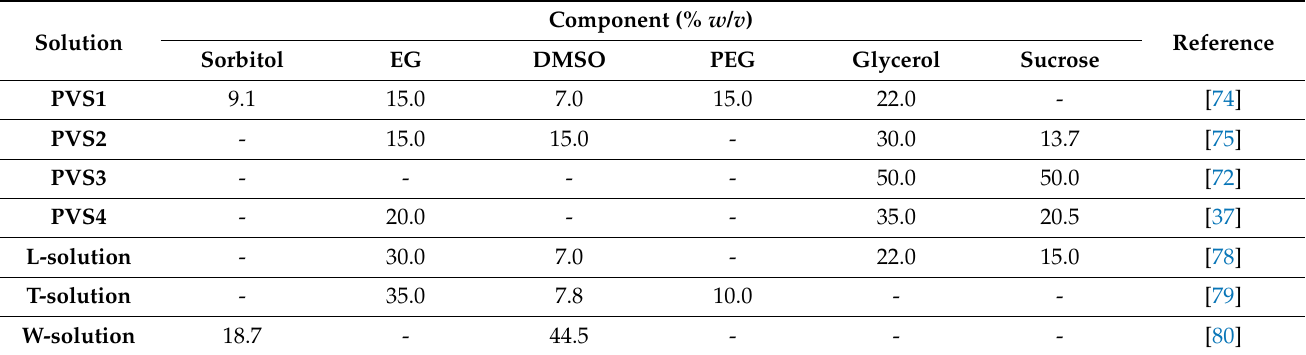
Table 3. Composition of plant vitrification solutions